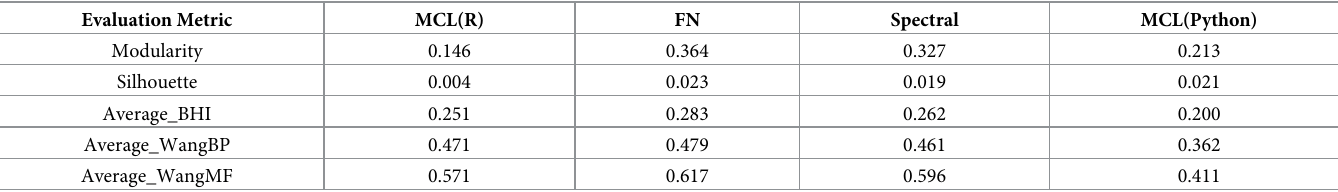
Table 3. Performance comparison of clustering algorithms.